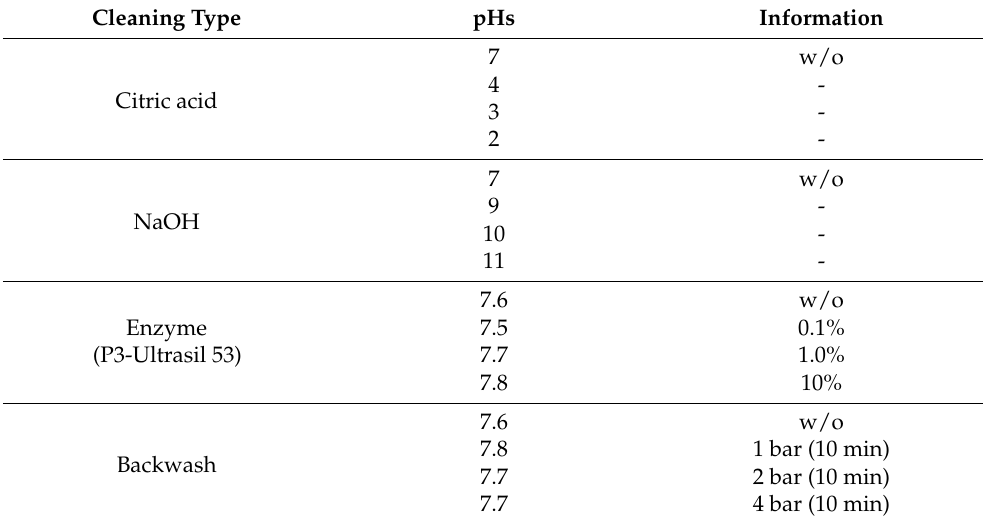
Table 4. Parameters for cleaning